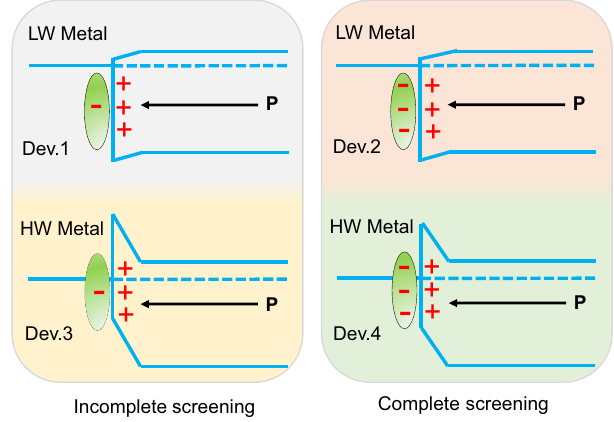
Fig. 1 Band diagrams for presenting our approach to unravel the origin of ferroelectric resistance switching. A low-work-function (LW) metal will be employed to form a nearly zero interface barrier with the ferroelectric semiconductor (top left and top right), whereas a high-work-function (HW) metal will be used to obtain a relatively high barrier (bottom left and bottom right). Meanwhile, the interfacial screening of ferroelectric polarization charges is introduced into ferroelectric memristors: the left two panels indicate incomplete screening while those on right dictate complete screening. In total, four kinds of devices, termed Dev. 1, Dev. 2, Dev. 3, and Dev. 4, are created for this study. The black arrows in the band diagrams show polarization orientations. Both polarization charges and screening charges are illustrated at the right and left of interfaces,